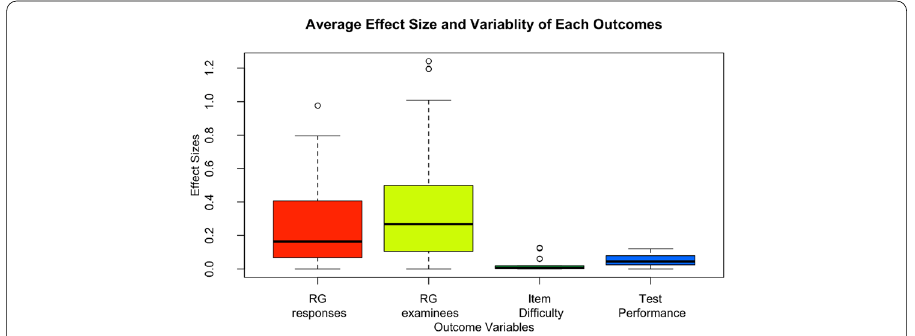
Fig. 2 Average effect size and variability of each outcome variables. RG responses responses identified, RG examinees